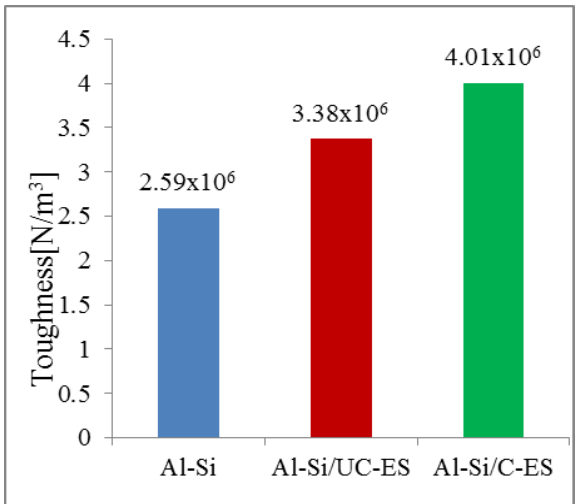
Fig. 12. Comparison of toughness for control sample and the two composites